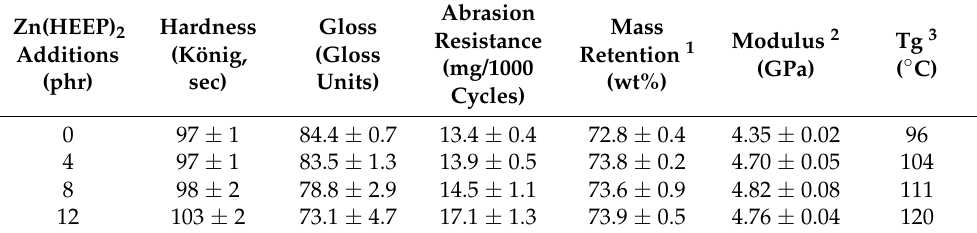
Figure 6. EDS mapping of UV films with different positions and Zn(HEEP) 2 addition. ( a ) Specified smooth area of Zn(HEEP) 2 -containing UV film, ( b ) specified particle area of Zn(HEEP) 2 -containing UV film, ( c ) specified particle area of the raw UV film. Table 3. The film properties of UV films with different Zn(HEEP) 2